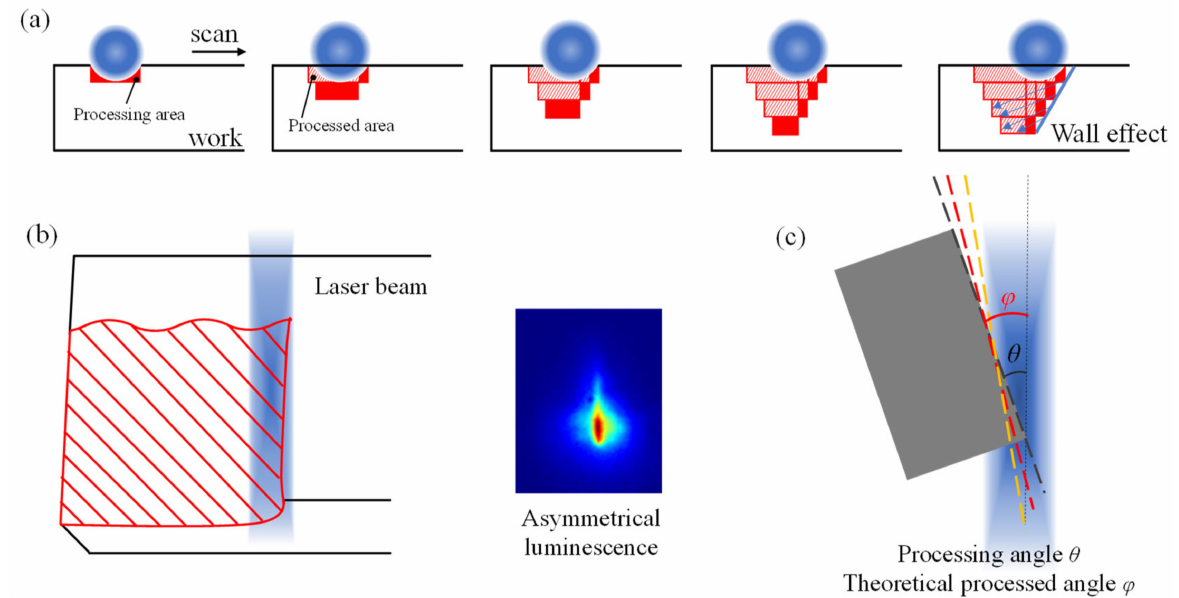
Figure 13. Schematics of the PLG mechanism at a pulse pitch of 0.2 µ m: ( a ) longitudinally along the direction of the laser; ( b ) horizontally perpendicular to the direction of the laser; ( c ) processing angle θ and theoretical processed angle ϕ